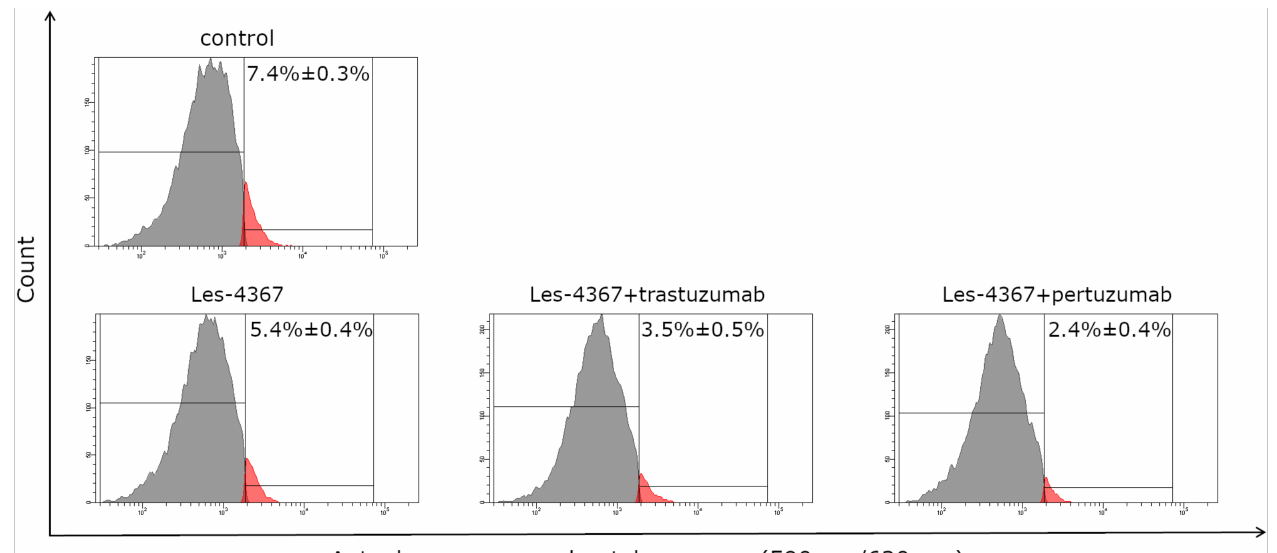
Figure 6. Flow cytometry analysis of autophagy induction in AGS human gastric cancer cells after 24 h incubation with Les-4367 alone and combined with trastuzumab or pertuzumab (Les-4367 + trastuzumab, Les-4367 + pertuzumab). The numerical value in the upper part of the dot plot = the percentage of cells with autophagy. Grey part of histogram- non-autophagic cells, red part of histogram- autophagic cells. The obtained results are presented as mean values ± SD obtained from three independent experiments (n = 3) done in